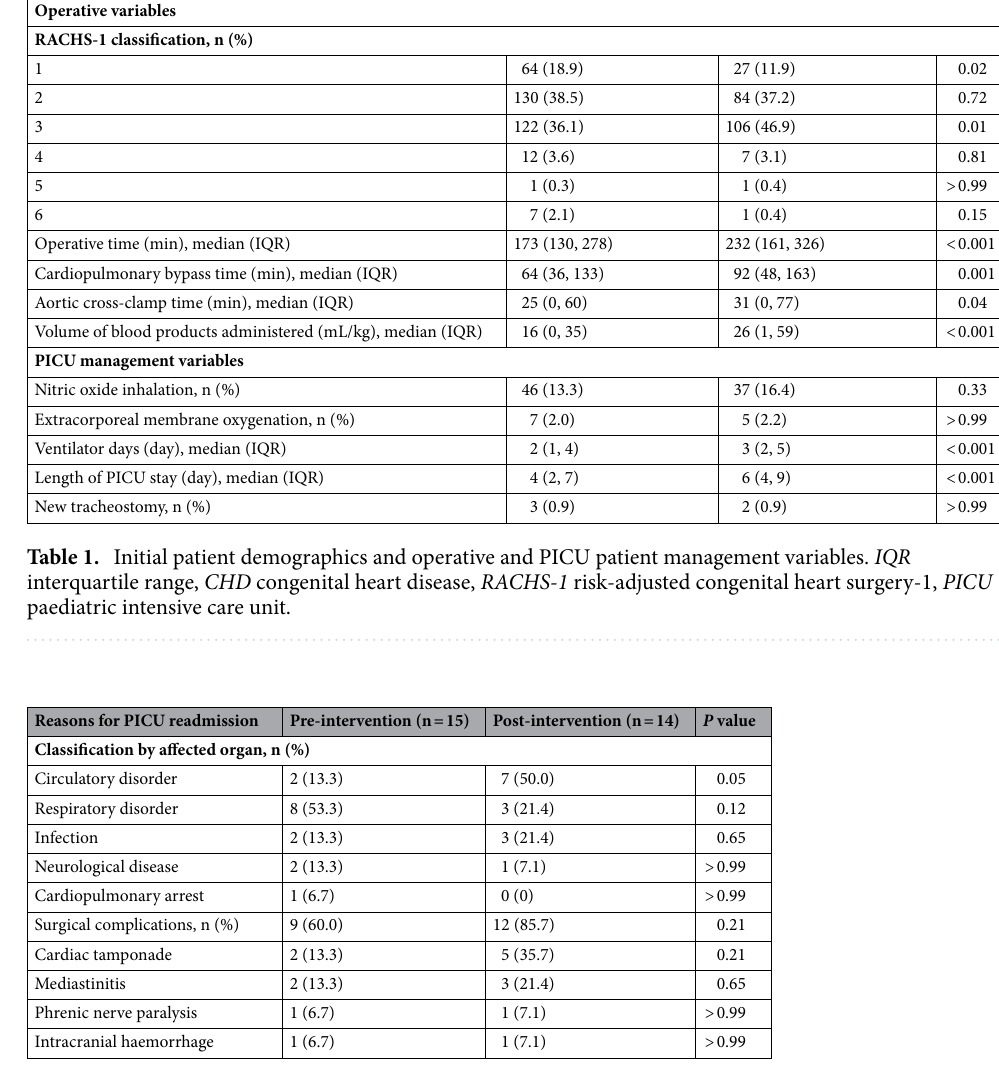
Table 2. Reasons for PICU readmission. PICU paediatric intensive care